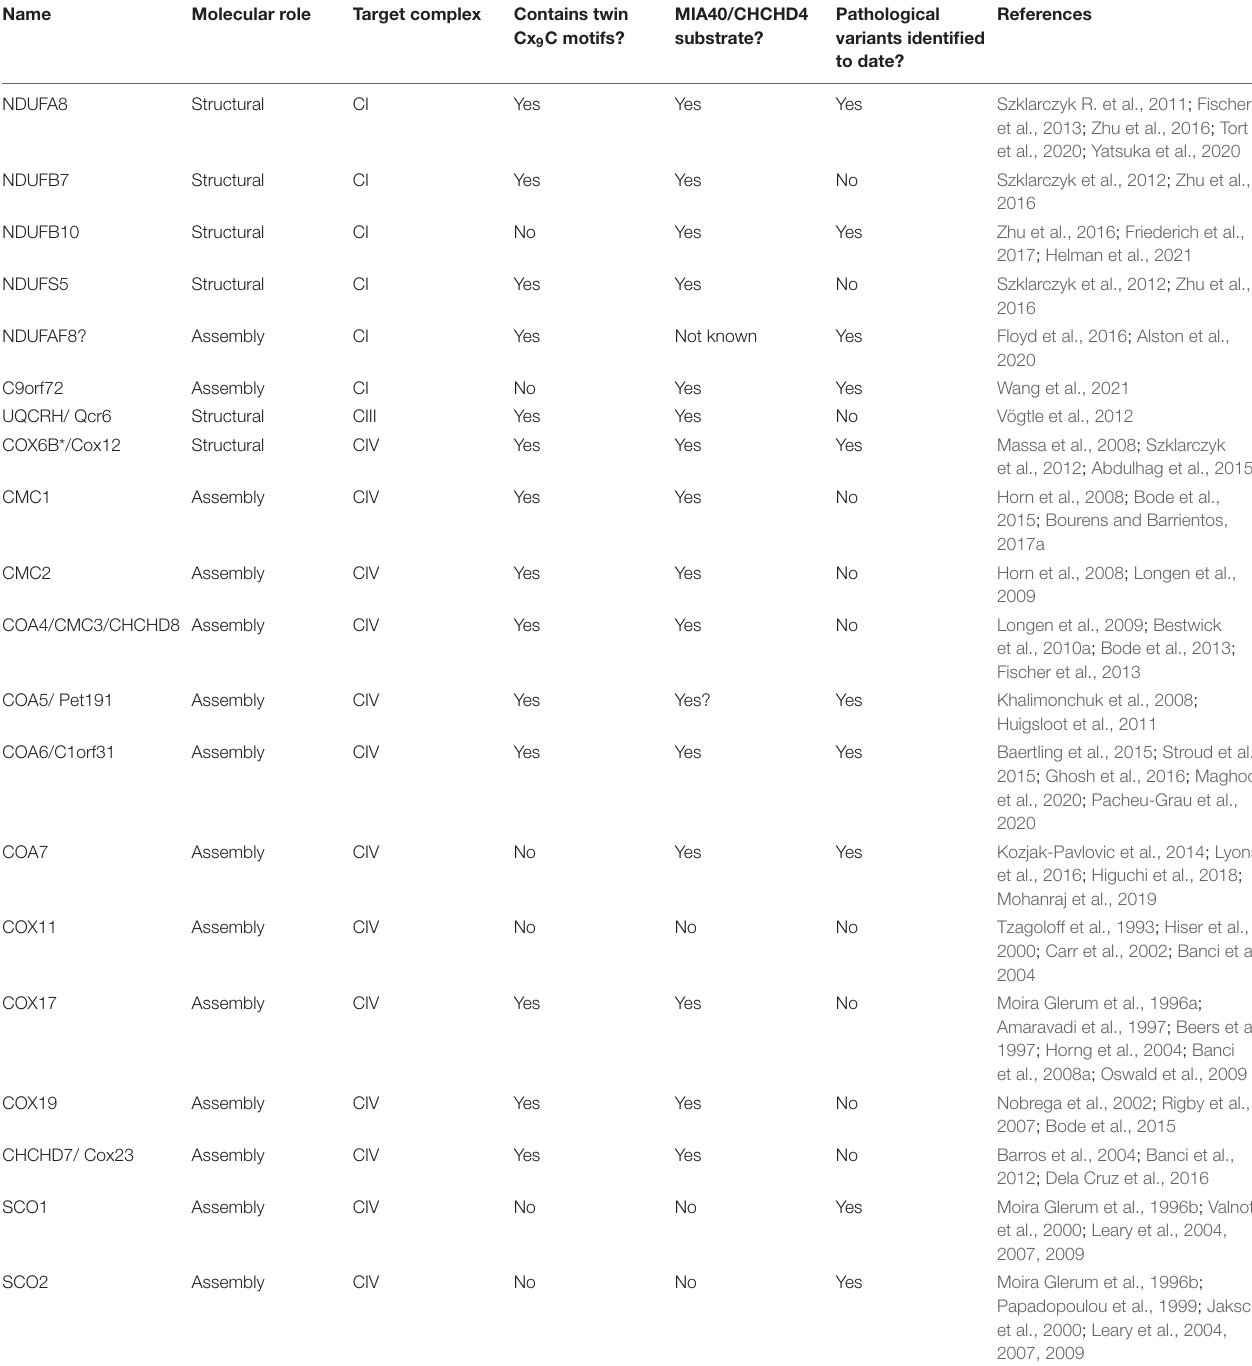
TABLE 1 | IMS-located Cys-rich structural subunits of the ETC complexes and assembly